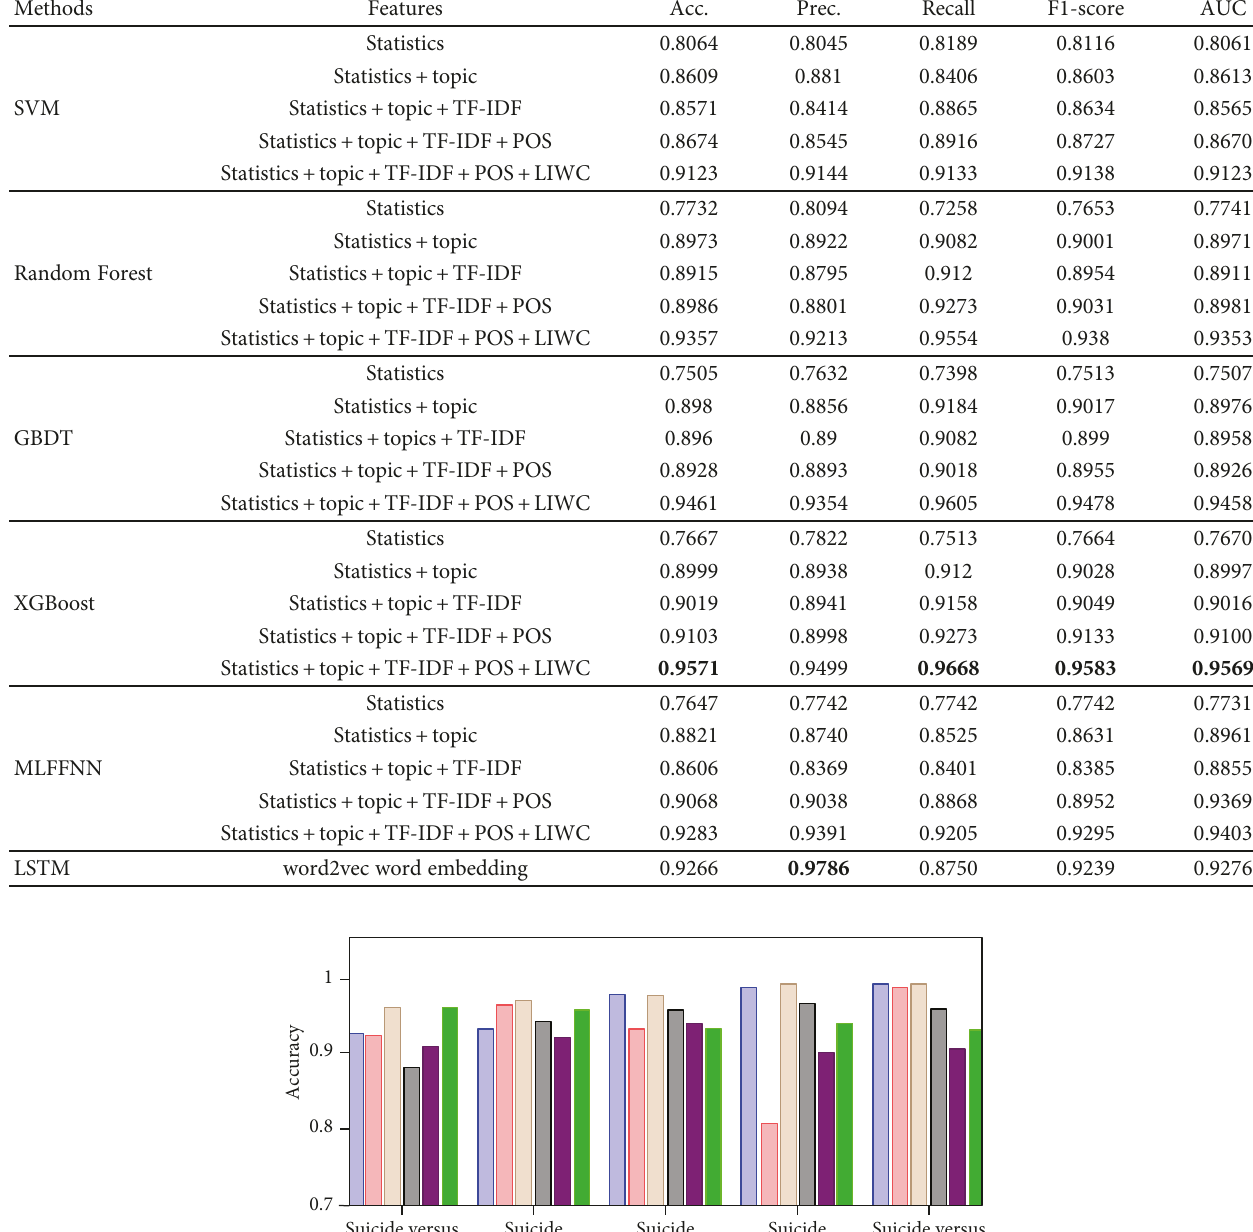
Table 5: Comparison of di ff erent methods using di ff erent